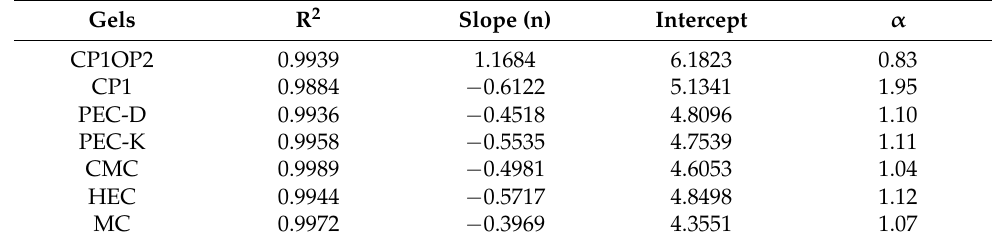
Table 7. Correlation coefficient (R 2 ), slope (n), intercept values, and α of the linear regressions obtained by fitting the rheogram data of gels subjected to PCA to the Cross mathematical model.